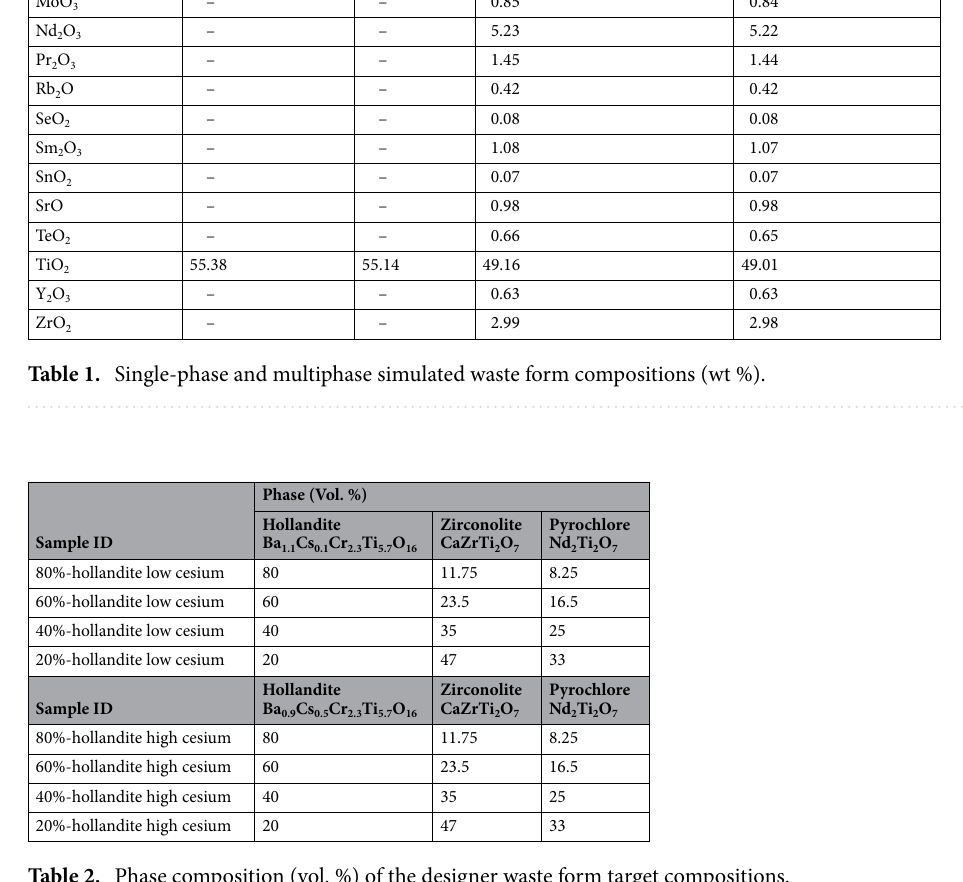
Table 2. Phase composition (vol. %) of the designer waste form target